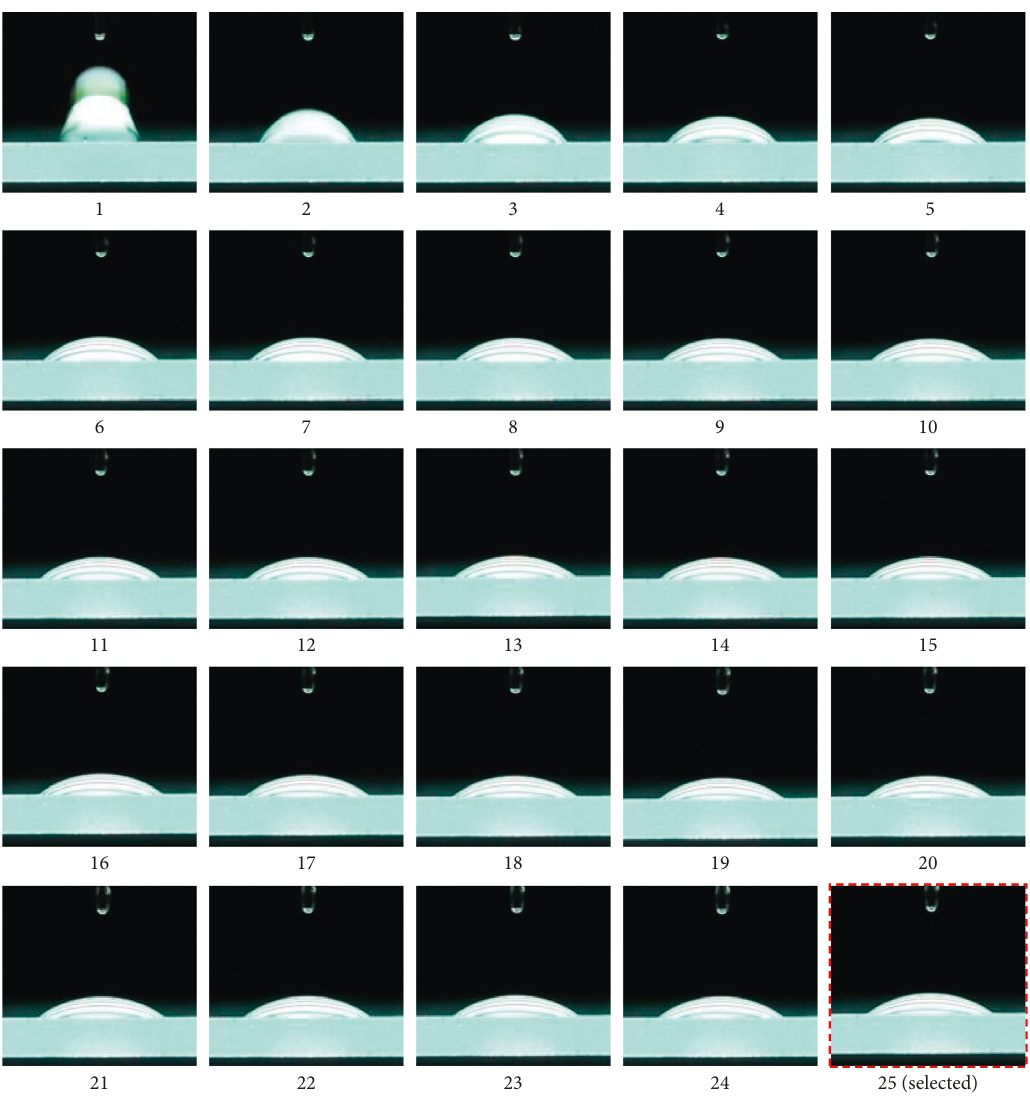
Figure 3: Image of dropped oil obtained from the VDO